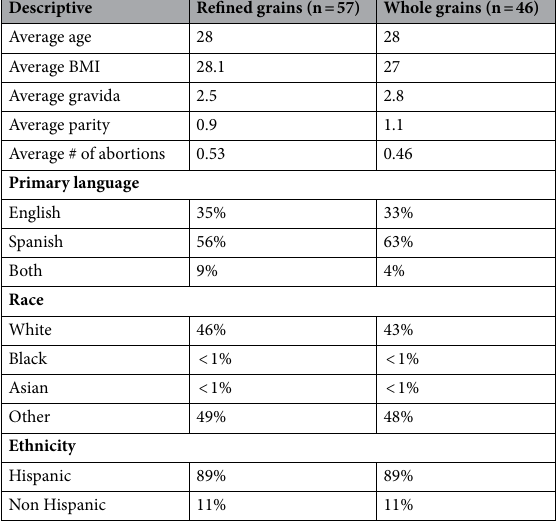
Table 1. Maternal descriptive information at enrollment for microbiome